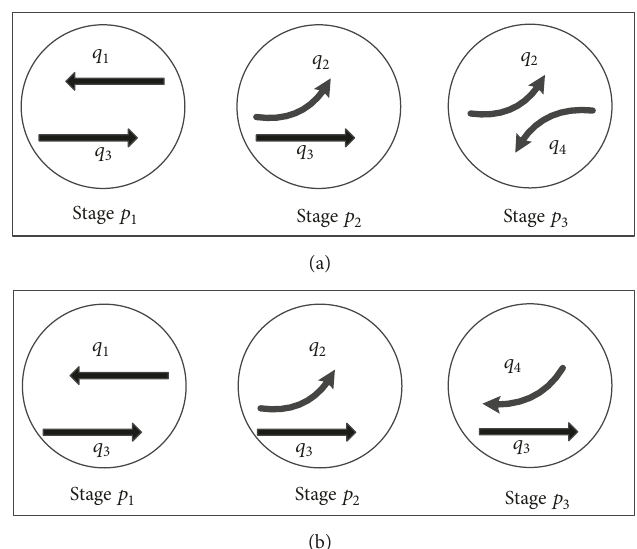
Figure 5: Examples of three stages sharing